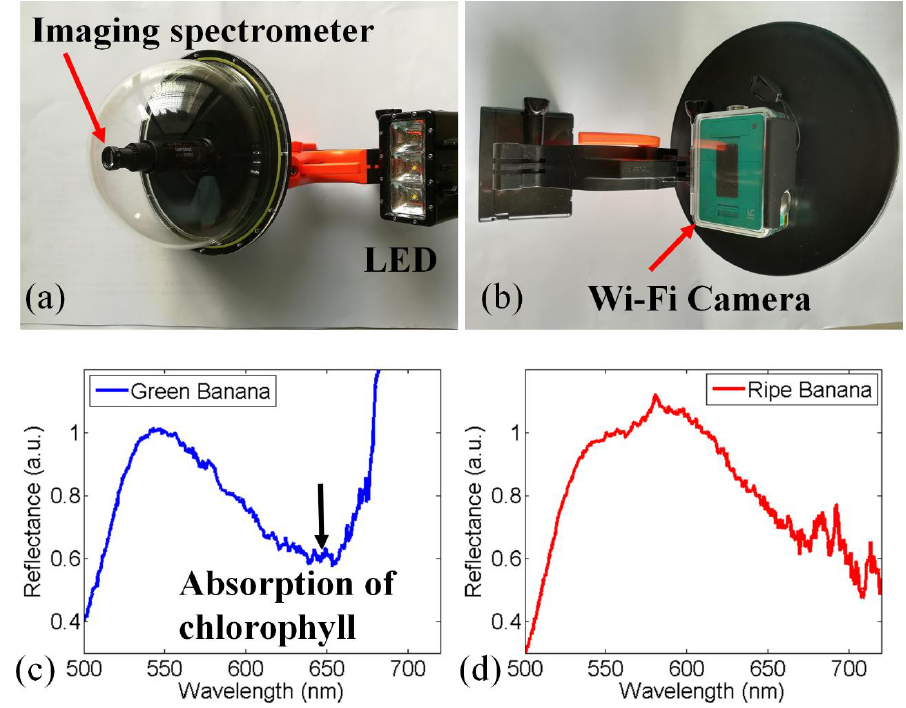
Figure 4. The compact imaging spectrometer can be installed in a waterproof dome port for underwater detection. ( a , b ) show the front and back views of the underwater spectral detection system, respectively. We sank this system into a water tank to measure the reflectance from bananas. ( c , d ) show the reflectance spectra from green and ripe bananas, respectively.